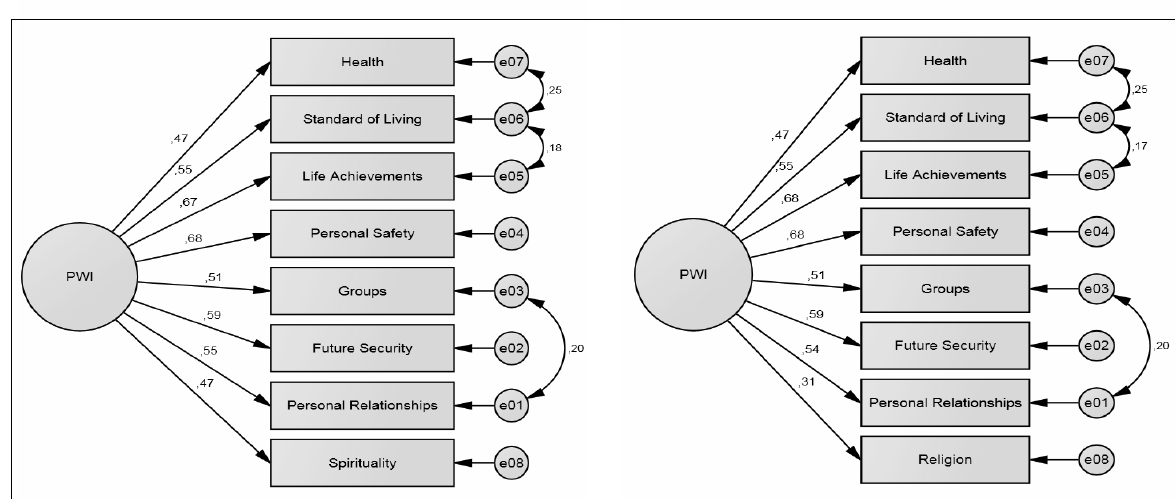
Figure 1. Con fi rmatory factor analysis of the PWI with the spirituality item and the religion item, with combined data from Chile and Brazil, standardized